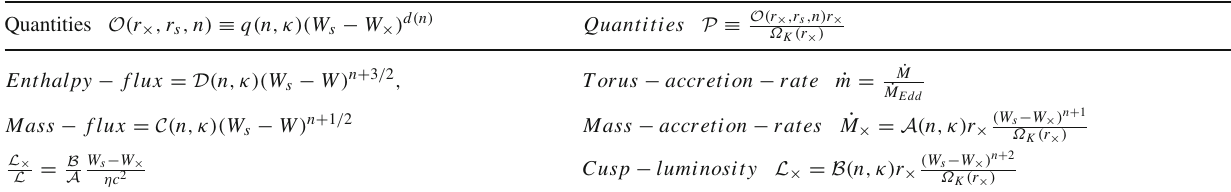
Table 2 Quantities O and P . L × / L stands for the fraction of energy produced inside the flow and not radiated through the surface but swal- lowed by central BH . Efficiency η ≡ L / ˙ Mc 2 , L representing the total luminosity, ˙ M the total accretion rate where, for a stationary flow, ˙ M = ˙ M × , W = ln V ef f is the potential of Eq. (7), Ω K is the Kep-